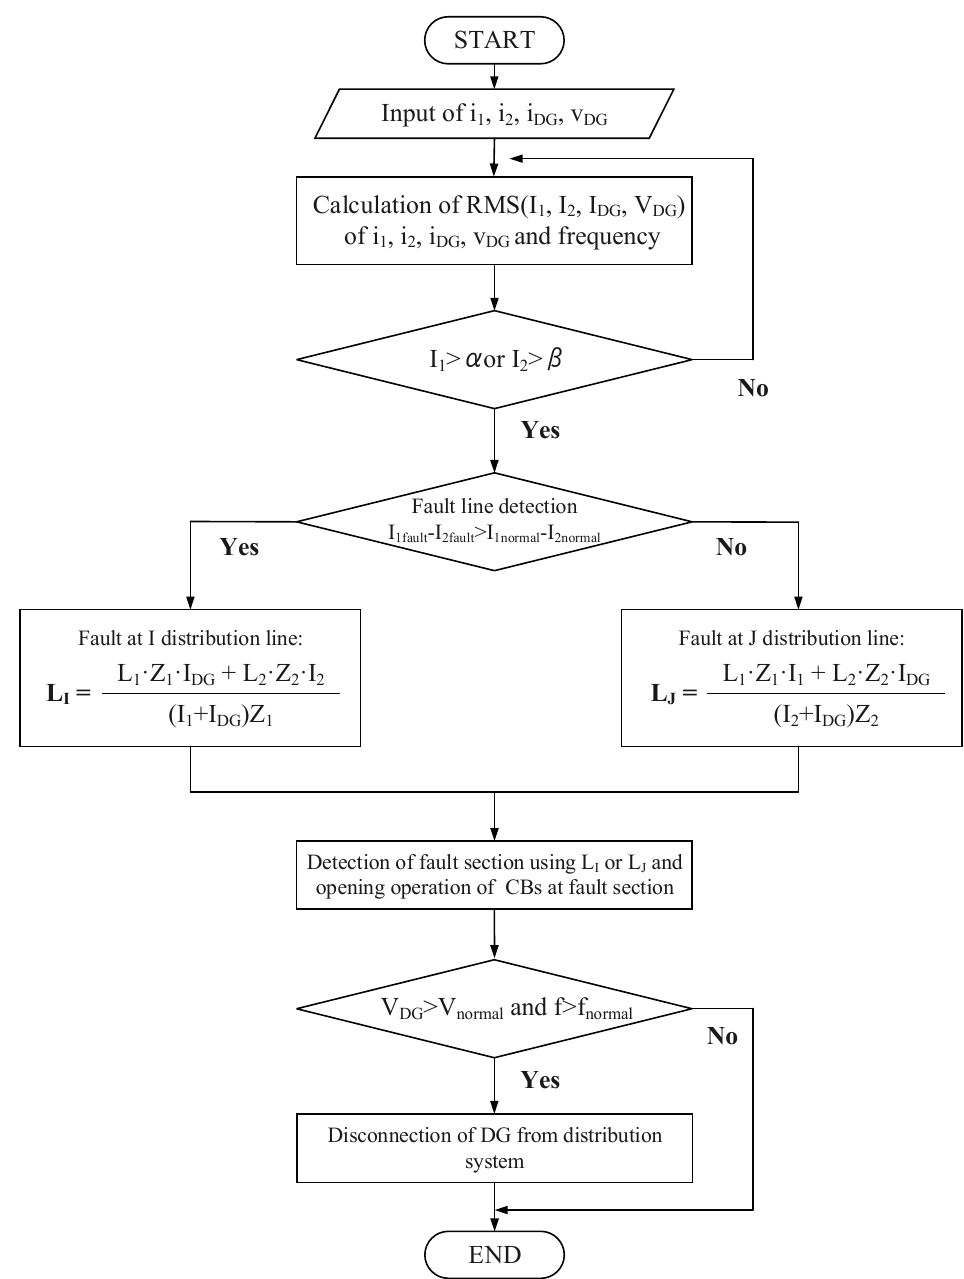
Figure 5. Flowchart of new protection method in the loop distribution system considering DG.